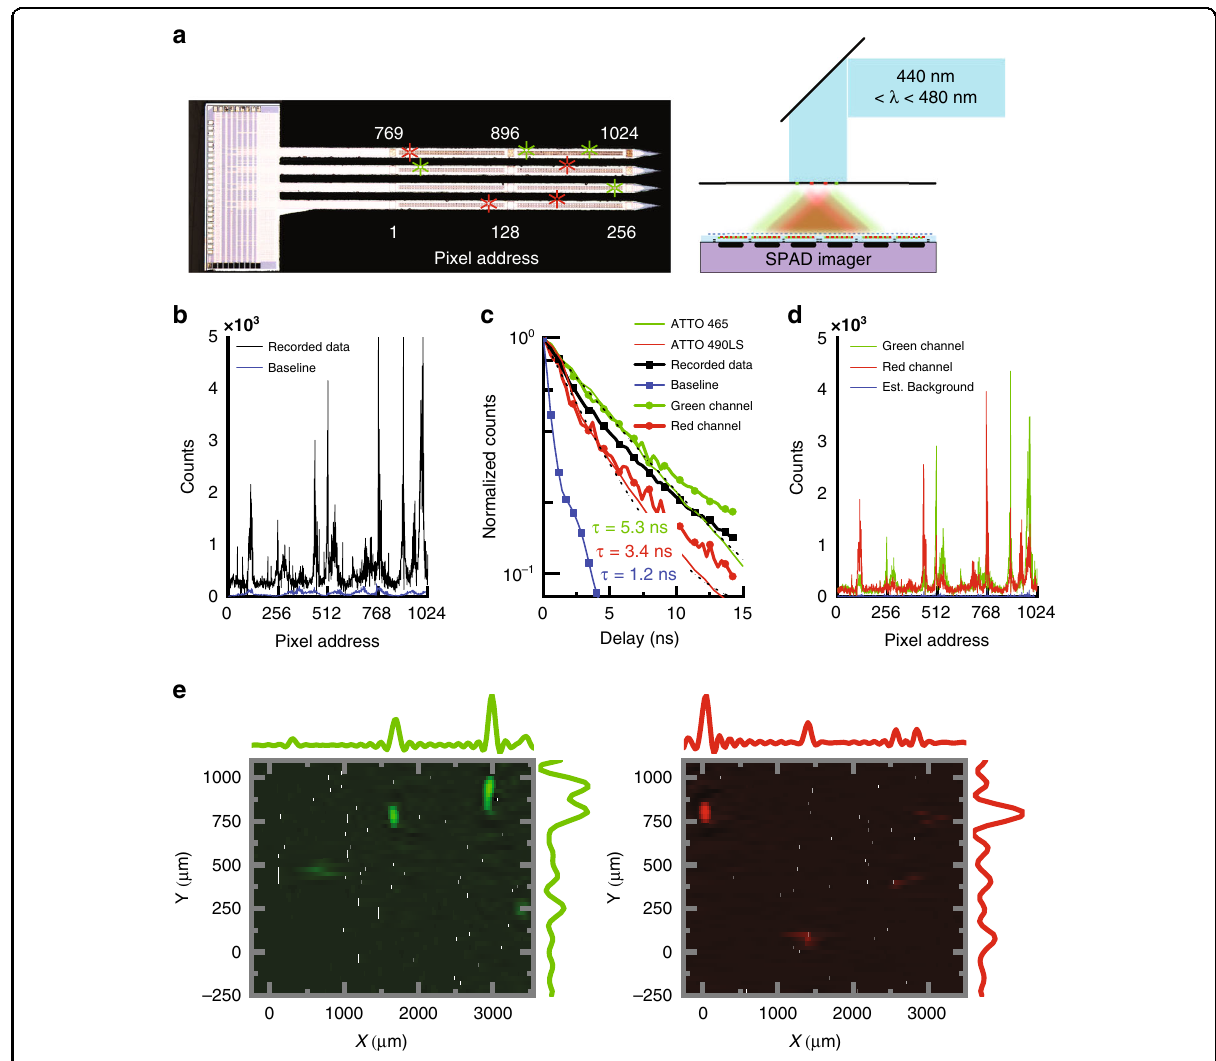
Fig. 4 Multi-wavelength lens-less imaging using angle-sensitive pixels. a Photomicrograph of the fl uorescent pinhole array overlaid on the chip. b 30 µMol l − 1 ATTO 465 and ATTO 490LS fl uorescent dye is dispersed in 1.5% agar simulating scattering tissue. The agar is overlaid on a pinhole array and illuminated from the back. b Recorded data from MIMAS imager chip. c Calibration of recorded lifetimes for 30 µMol l − 1 green, red and undyed agar. Time series for the mean recorded data, separated in green and red color channels through blind source separation. d Data separated into color channels after blind source separation. e Inverse image for both wavelength channels with detail plots representing the summation in the X and Y